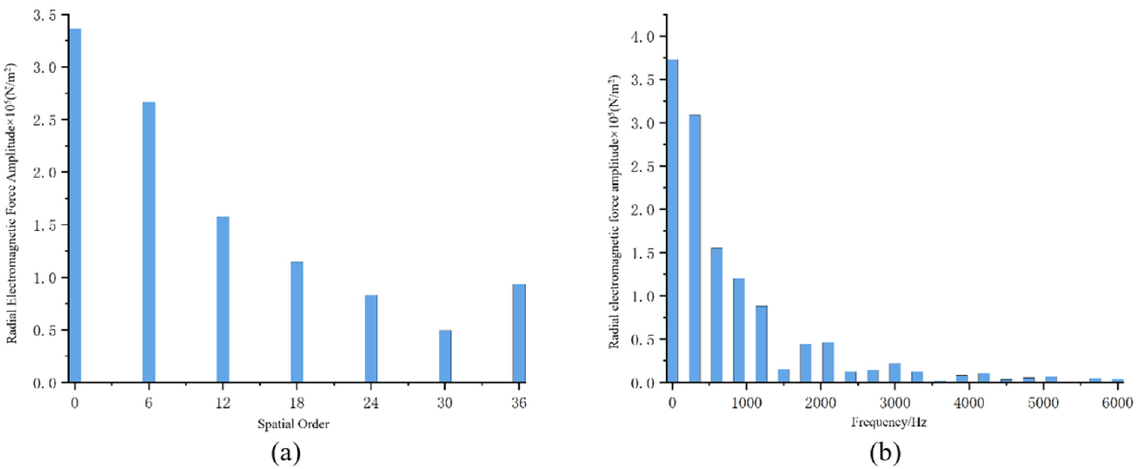
Figure 4. ( a ) The 0.01 s radial electromagnetic force distribution with spatial order; ( b ) radial electromagnetic force distribution in time–frequency at a point on the stator tooth end.